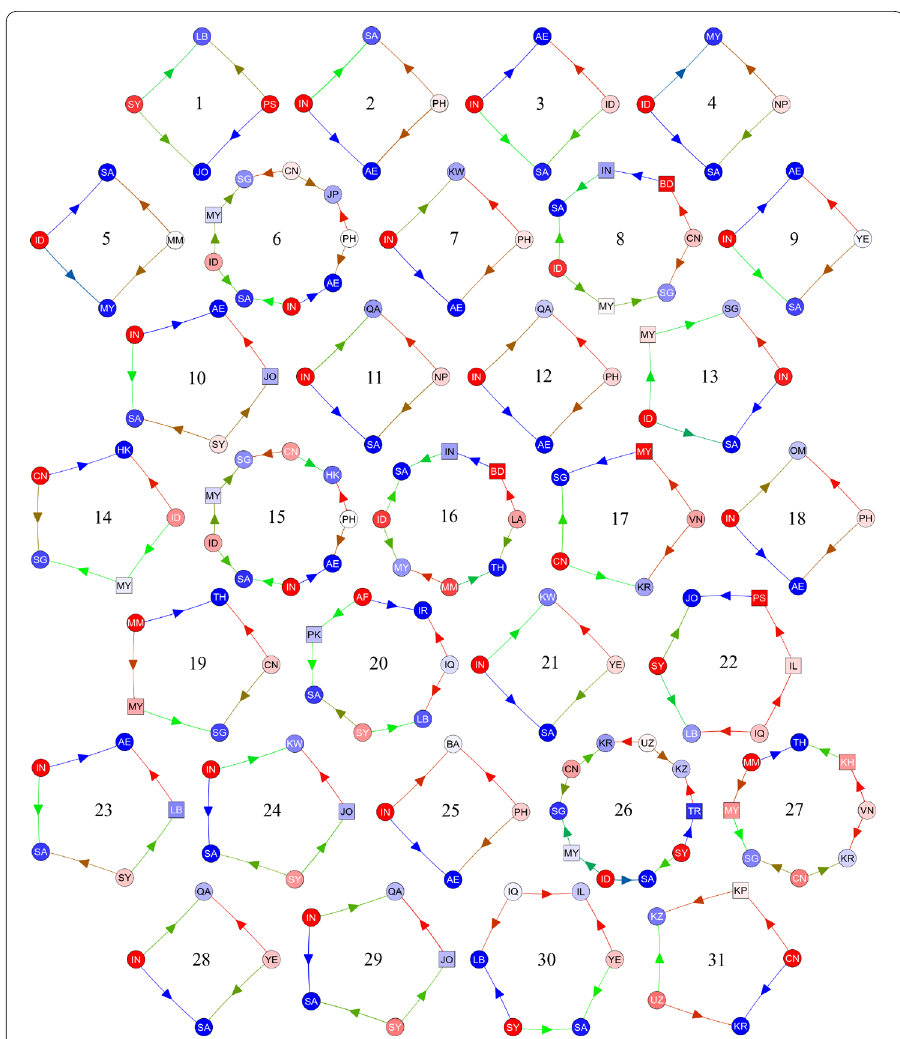
Figure 10 Cyclic patterns of Asian migration. 1-cycle generators for the 2015 Asian net migration network. Nodes are colored red if, relative to countries in the cycle, more migrants are moving out than coming in, and blue otherwise. Darker shades represent larger numbers. Square nodes represent transitory countries while circles denote sources and sinks